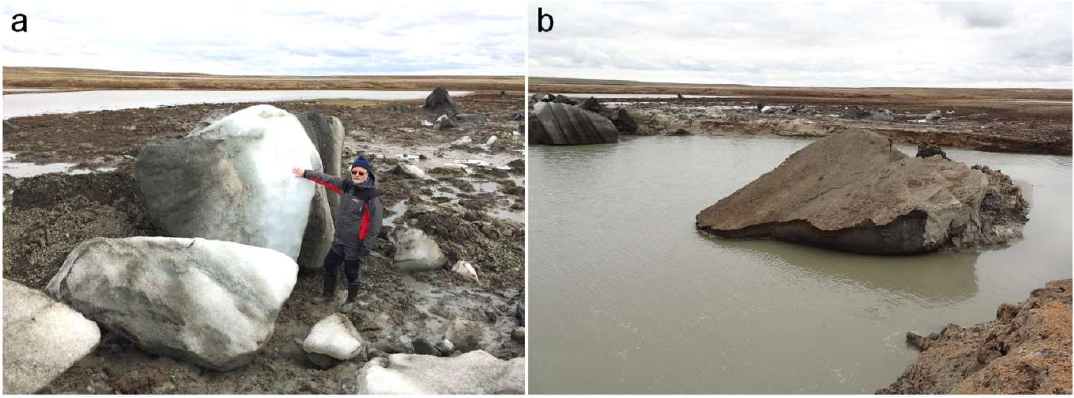
Figure 4. Massive fragments of ground ice ( a ) and frozen sandy loam rock ( b ) ejected by the explosion, 2 July 2017 (photos by Vasily Bogoyavlensky).